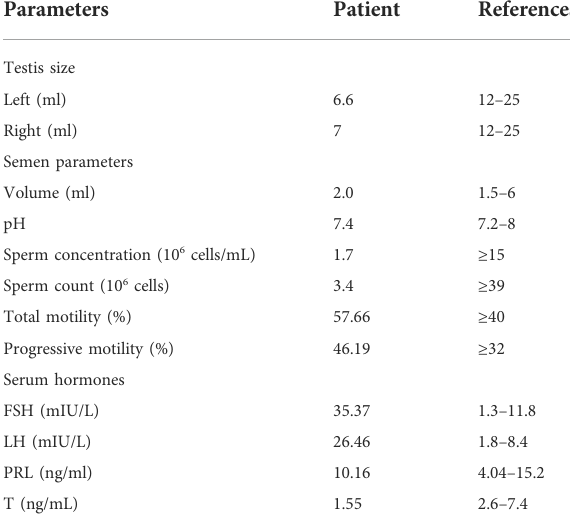
TABLE 1 Testicle volume, semen parameters, and hormone pro fi